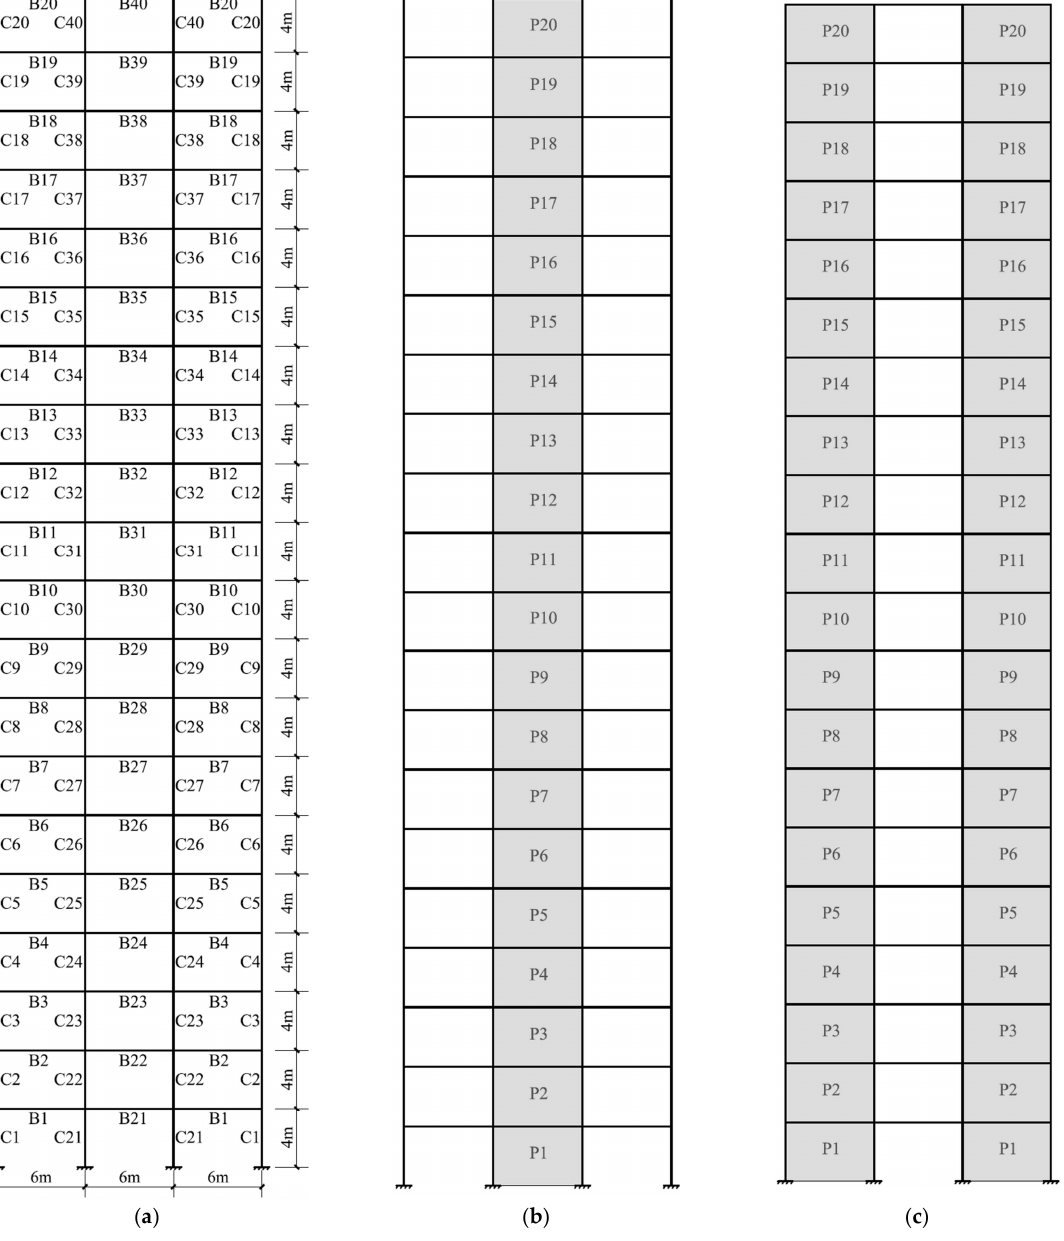
Figure 6. Twenty-story steel frame: ( a ) element group numbers; ( b ) SPSW1-20; and ( c ) SPSW2-20. Table 4. Genetic parameters of structures with different